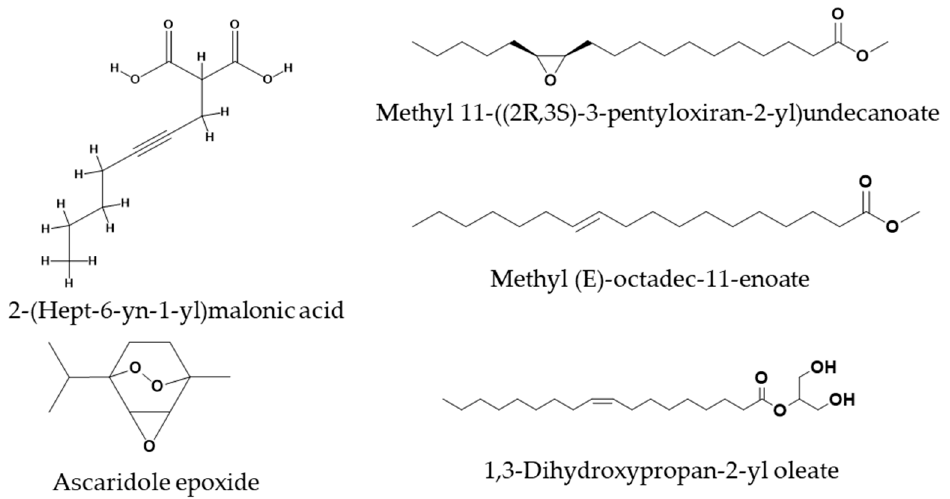
Figure 3. Main chemical components of the methanol extract of M. longipetala aboveground parts interpreted from GC-MS analysis.